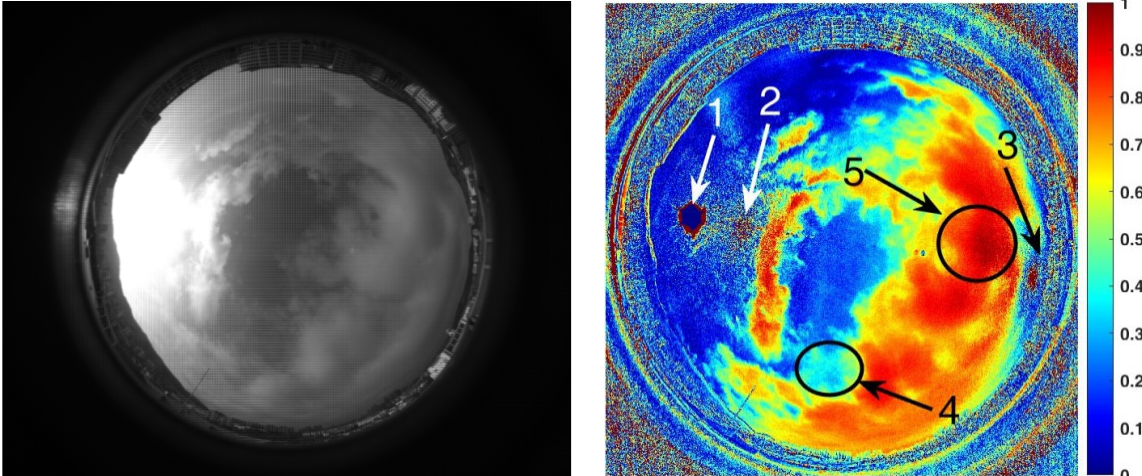
Figure 10. Cloudy sky image acquired by the polarization camera and the corresponding NPDDI distribution results. The cloud segmentation effect is obvious, and so is the comparison between thin clouds and thick clouds.